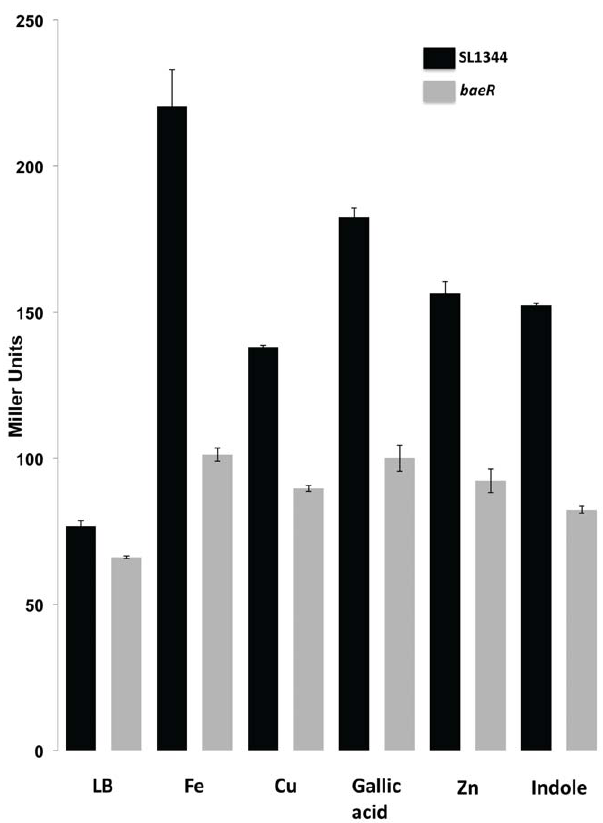
Figure 3.BaeR dependent induction of mdtA . b -galactosidase activities of the plasmid containing the mdtA promoter region fused with the promoter-less lacZ gene in a wild type (black columns) or baeR mutant (grey columns) background. The cells were grown in LB or LB supplemented with 1mM Iron Sulphate (Fe), 1mM Copper sulphate (Cu), 0.5mM Zinc Sulphate (Zn), 0.5mM of Gallic Acid or 2mM of Indole. Bars represent the mean of three biological replicates, error bars, SD.